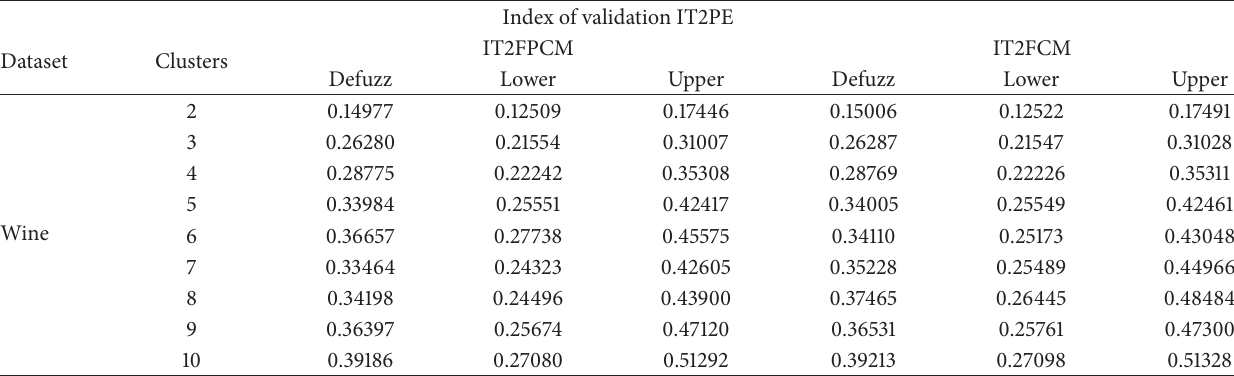
Table 6: Results of the IT2PE validation index to Wine dataset clustering using IT2FPCM and IT2FCM algorithm with 𝑚 = [1.5, 2] and 𝜂 = [1.5, 2.5] as parameters.